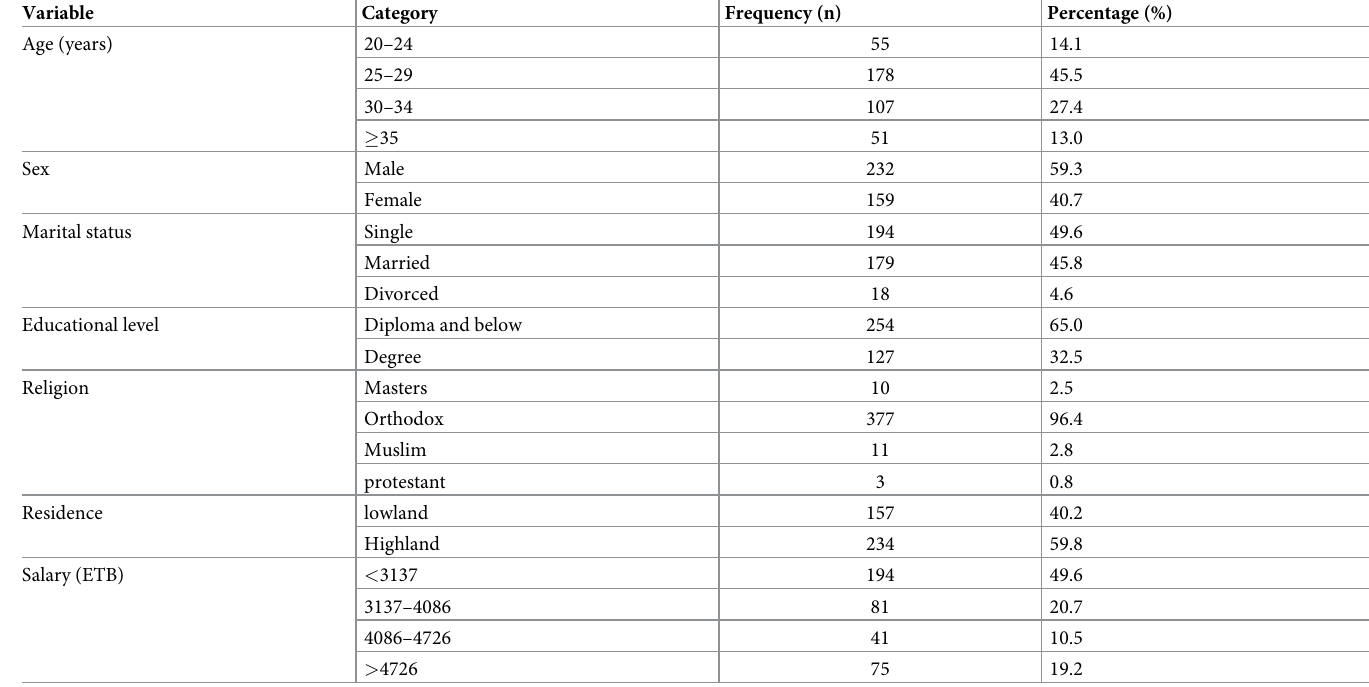
Table 1. Socio-demographic characteristics of primary hospital employees in North Gondar, Ethiopia, 2017 (n =